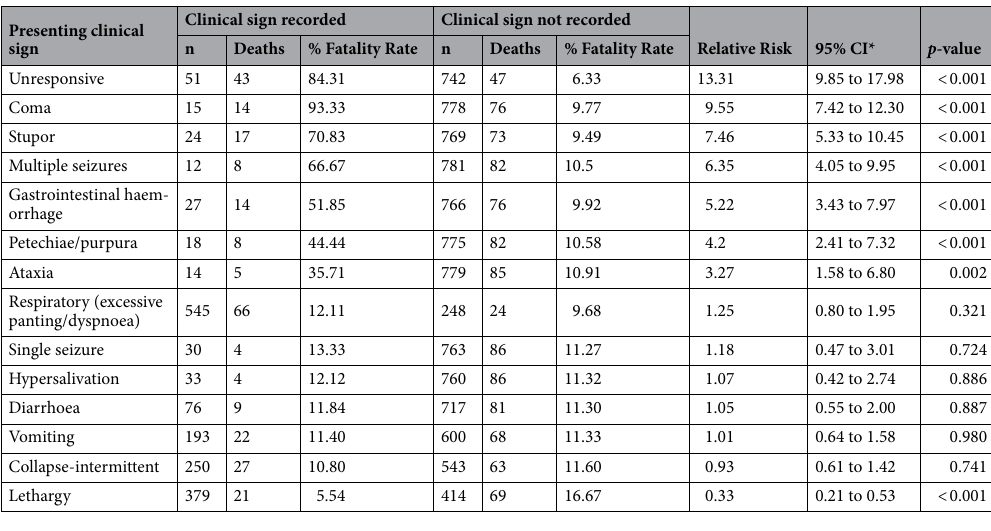
Table 2. Proportional fatality and relative risk for death overall (including euthanasia, unknown method and unassisted) in dogs recorded with specific clinical signs of heat-related illness cases presenting to primary-care veterinary practices in the UK between 2016 and 2018. Relative risk describes the risk ratio of death in heat- related illness cases recorded with this clinical sign compared to cases without this clinical sign. *CI confidence interval, n = 793.